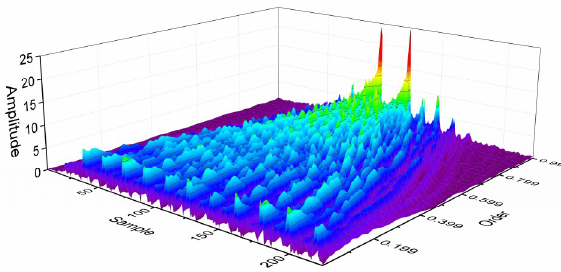
Figure 2. Results of Multiorder FRFT with single action in 3D (order: 0–1).